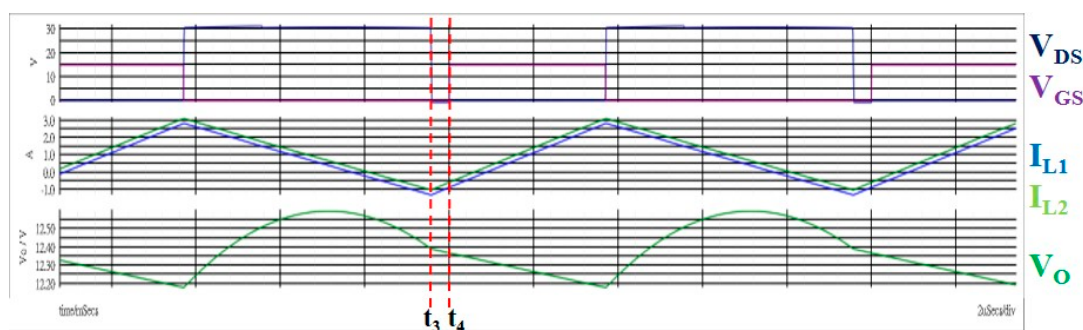
Figure 15. V GS 1 , V DS 1 , I L 1 , I L 2 , V 0 of input 30 V.